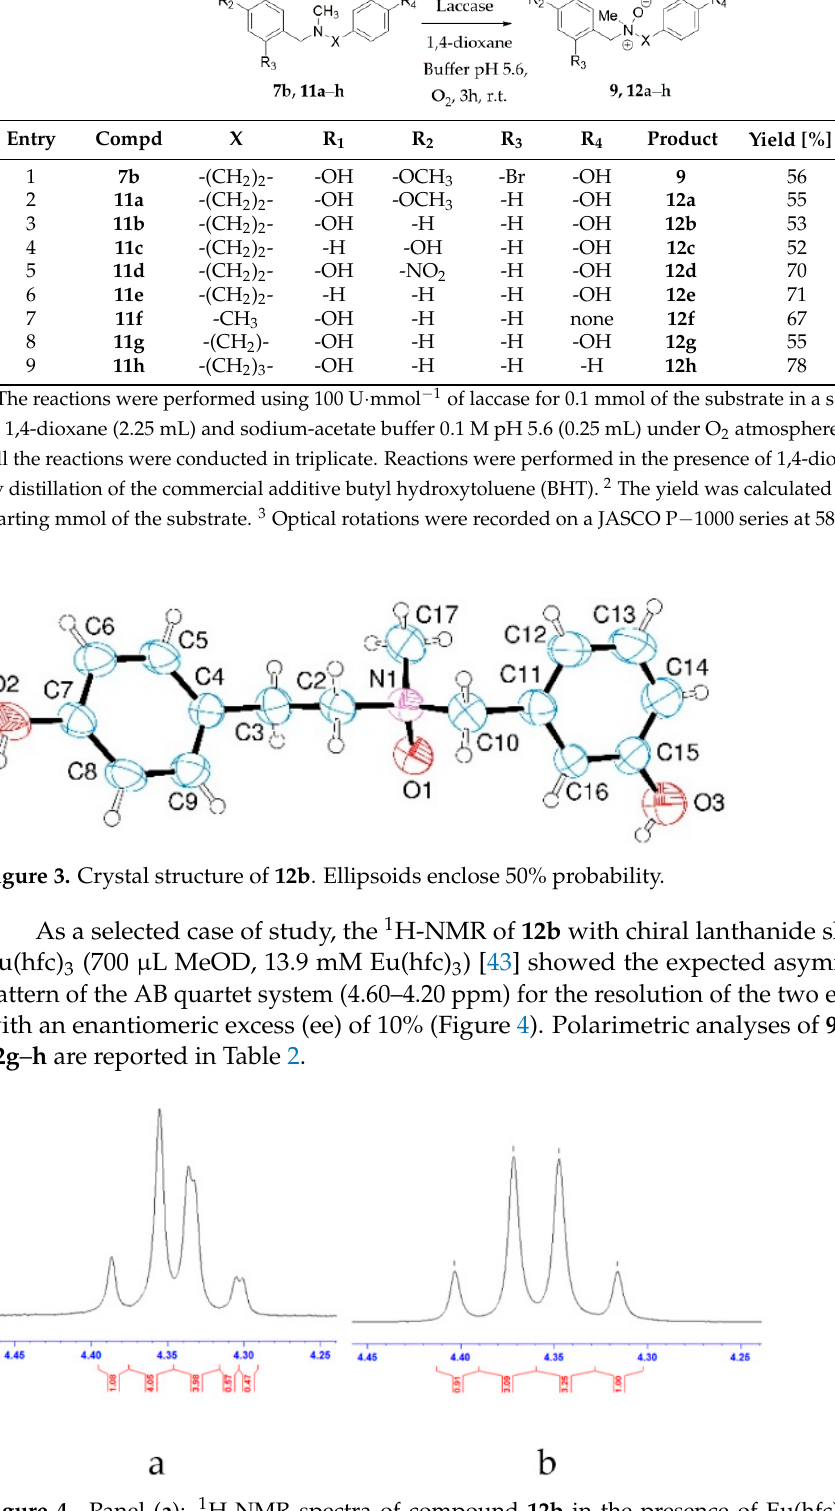
Figure 4. Panel ( a ): 1 H-NMR spectra of compound 12b in the presence of Eu(hfc) 3 ; panel ( b ): 1 H-NMR spectra of compound 12b in the absence of Eu(hfc) 3 .